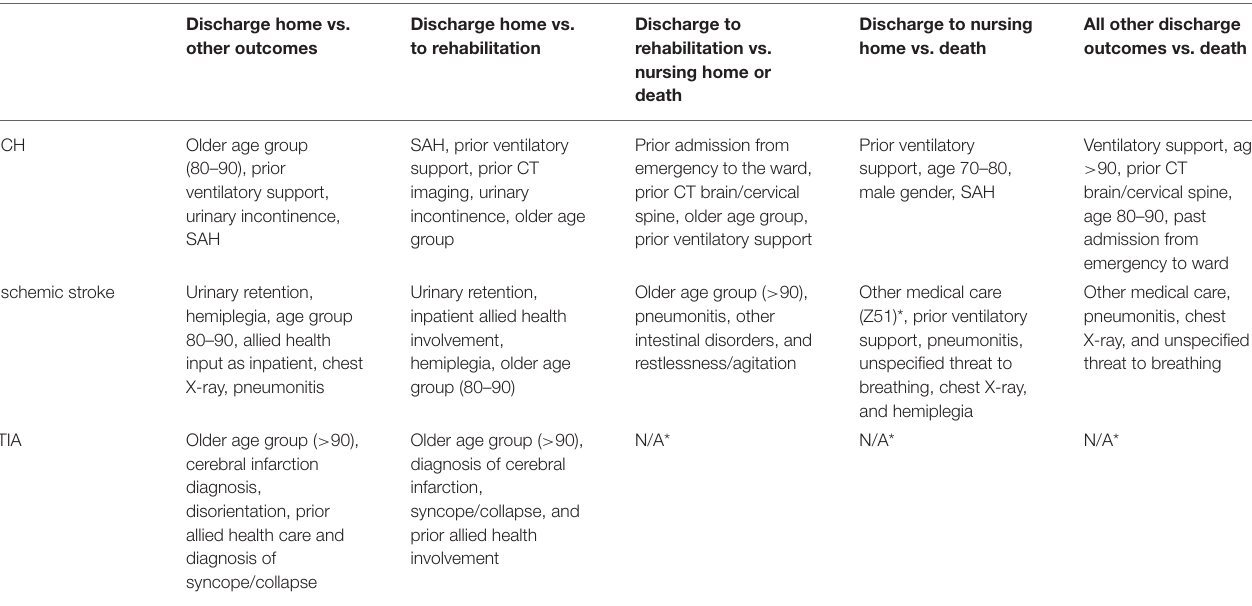
TABLE 6 | Selected predictive factors associated with the prediction